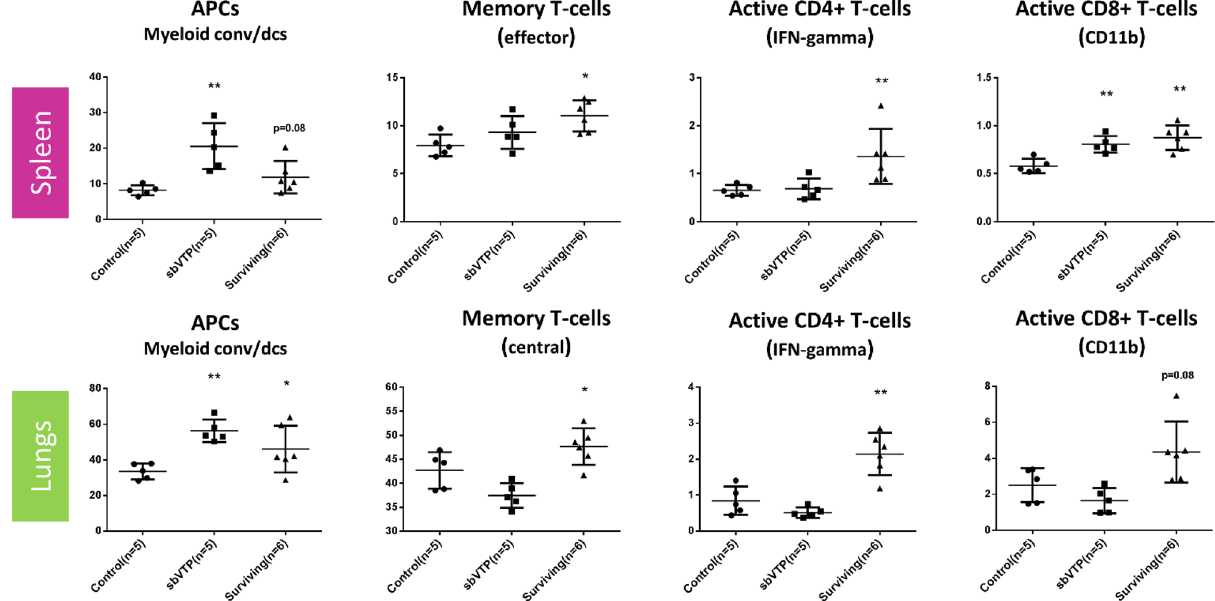
Figure 5. Flow data: cells’ sub-population percentage by organ. Left to right: first column represents antigen- presenting cells (APCs), second column represents memory T-cells (central/effector), third column represents active CD4 + T-cells as indicated by IFN-gamma positivity, and fourth column represents active CD8 + T-cells as indicated by IFN-gamma and CD11B positivity. CD45 +, CD4 +, Foxp3-were used to evaluate CD4 T effector cells. CD62L + CD44 + were used to evaluate central memory T cells and CD62L-CD44 + to evaluate effector or effector memory T cells. APCs antigen-presenting cells, conv conventional, dcs dendritic cells, IFN interferon, sbVTP sub-ablative vascular-targeted photodynamic therapy, surviving surviving animals. * P ≤ 0.05; ** P < 0.01, compared to